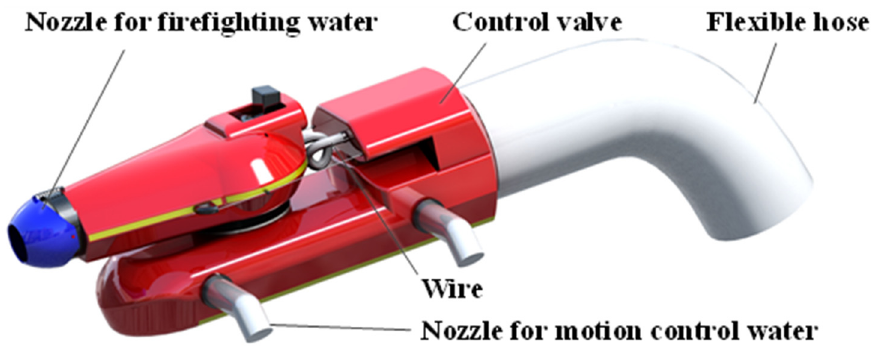
Figure 1. Conceptual drawing of flying-type firefighting system with the water jet actuator.